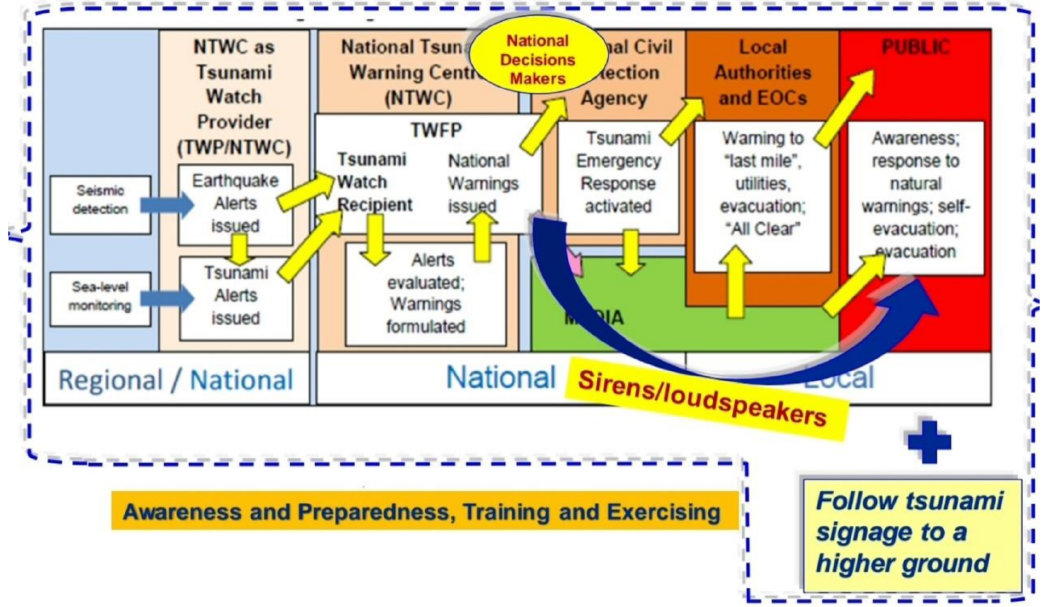
Figure 7. Suggested modifications to the NEAMTWS end-to-end alerting architecture [18]. The